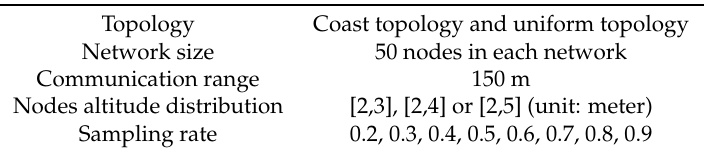
Table 4. The values of simulation